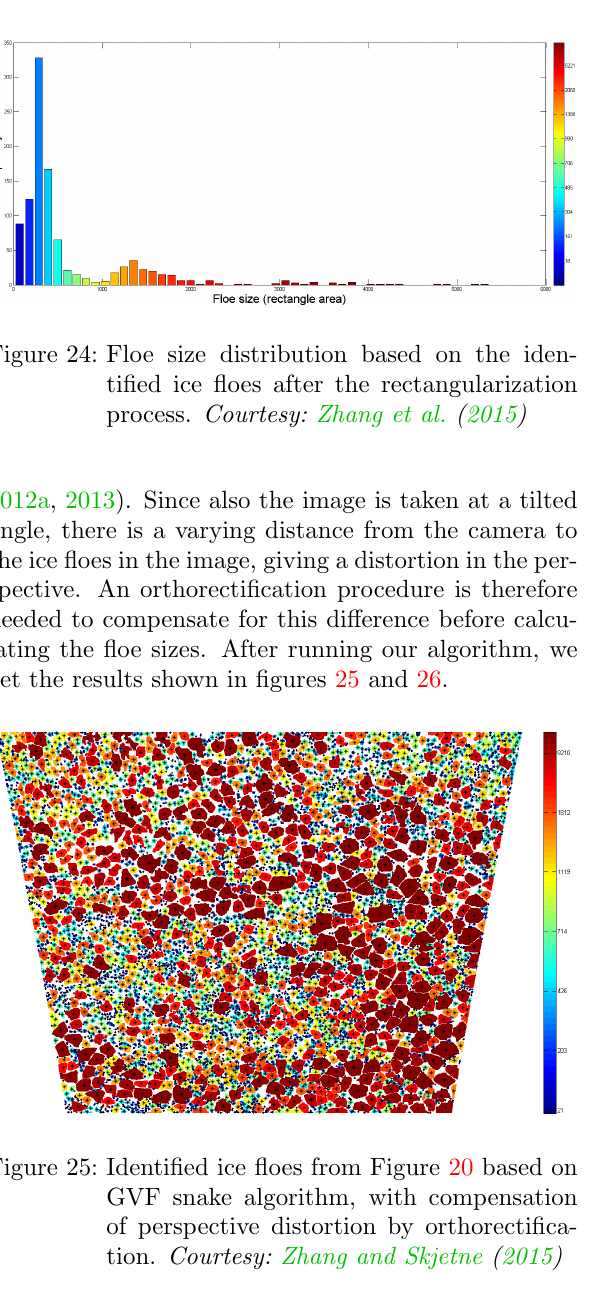
Figure 27: Arctic DP control system modules. Cour- tesy: Øivind K.